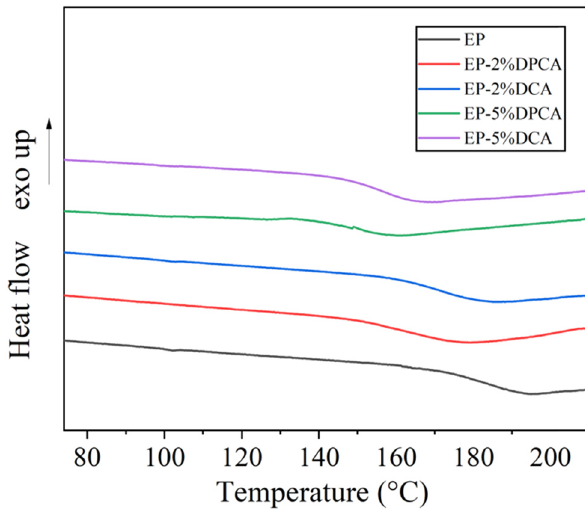
Figure 2: DSC curves of EP, EP - 2 wt% DPCA, EP - 2 wt% DCA, EP - 5 wt% DPCA, and EP - 5 wt% DCA in nitrogen.